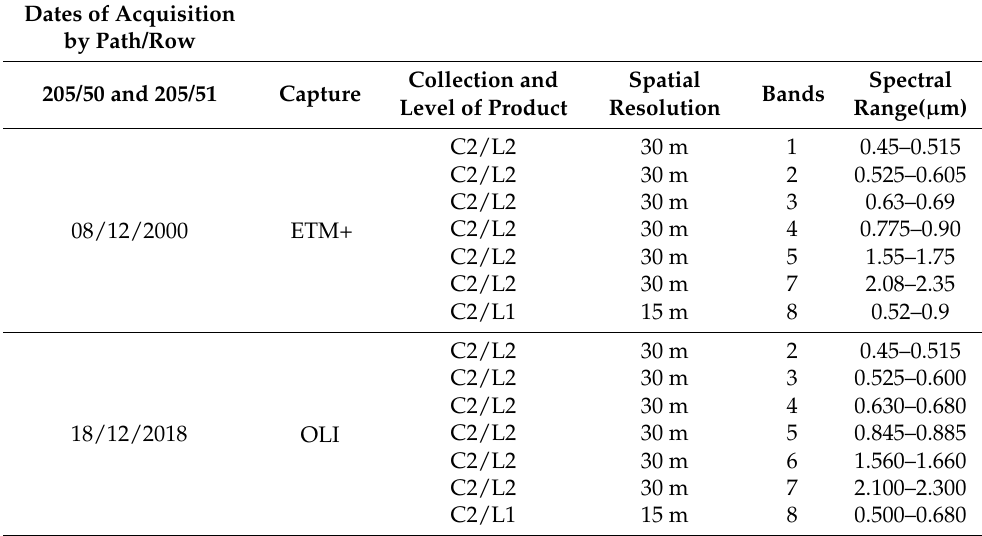
Table 1. Summary of the sensors and products used in the study and their corresponding characteristics. Dates of